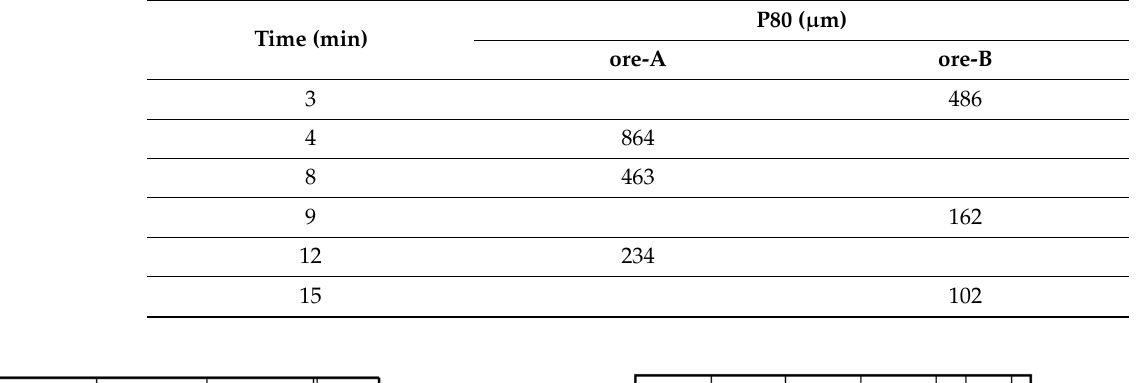
Table A3. Results of P80 with RRM.